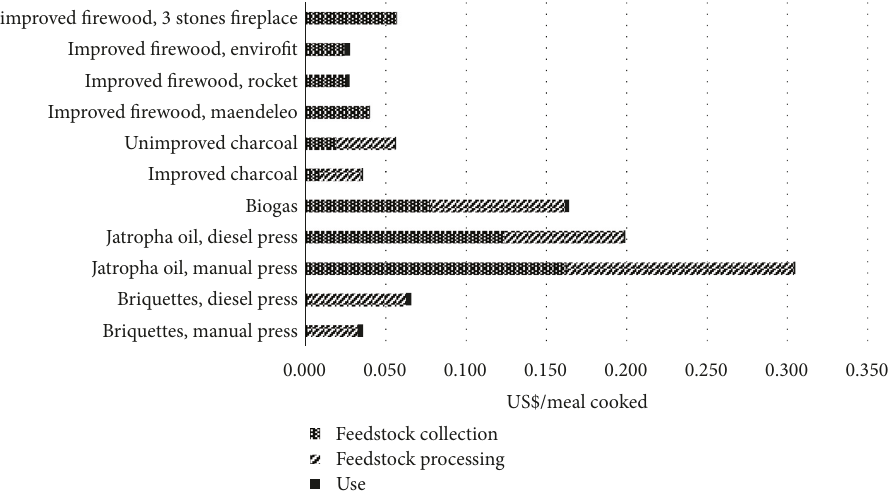
Figure 1: Life cycle costs per meal cooked (US$) incurred over the different energy value chains in rural Kitui, Kenya.